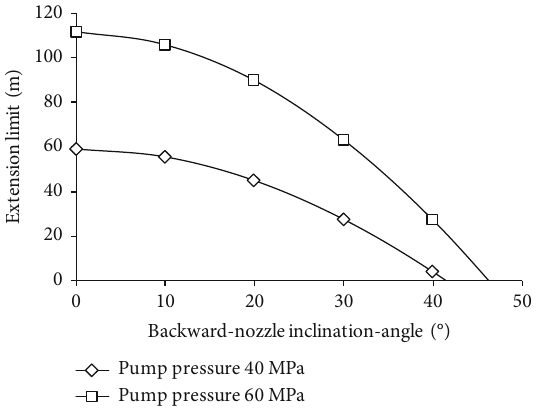
Figure 10: Extension limit in fl uenced by the backward nozzle inclination angle.